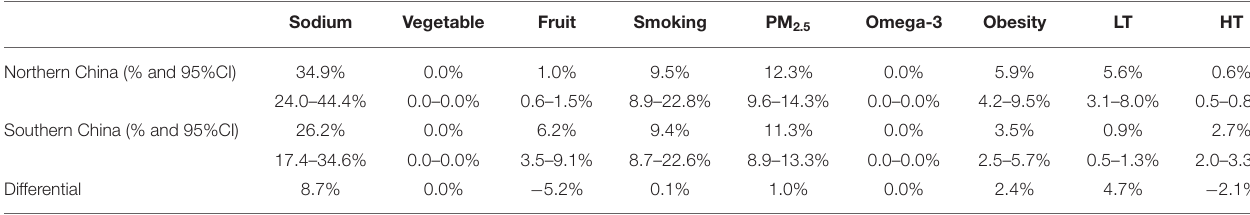
Differential LT, low temperature; HT, high temperature.